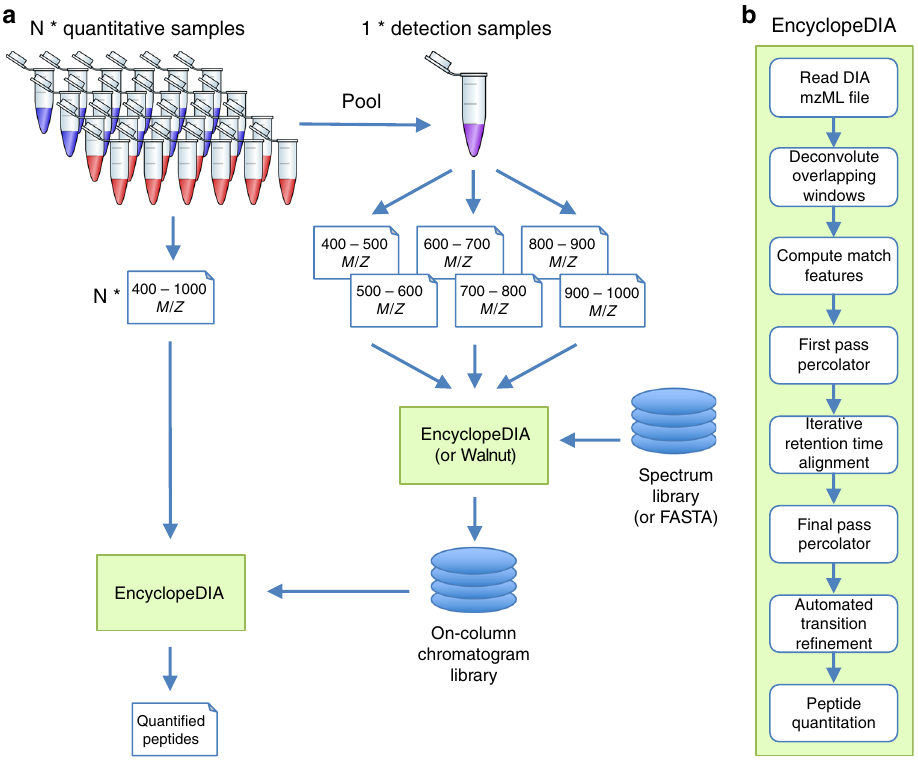
Fig. 1 An approach for quantifying peptides with chromatogram libraries. a The chromatogram library generation work fl ow. Brie fl y, in addition to collecting wide-window DIA experiments on each quantitative replicate, a pool containing peptides from every condition is measured using several staggered narrow- window DIA experiments. After deconvolution, these narrow-window experiments have 2 m/z precursor isolation, which is analogous to targeted parallel reaction monitoring (PRM) experiments, except effectively targeting every peptide between 400 and 1000 m/z. We detect peptide anchors from